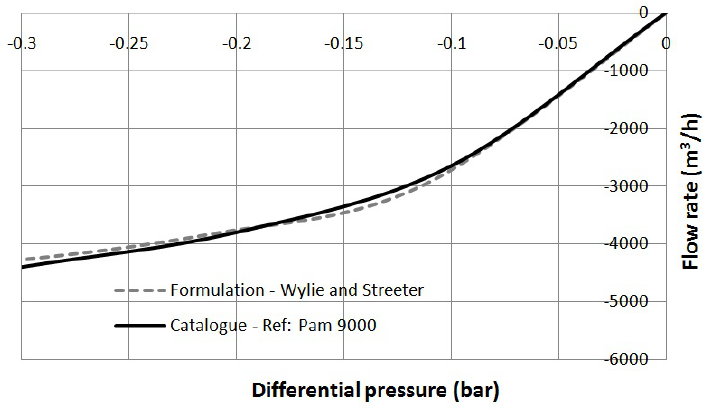
Figure 4. Characteristics of the air valve—Type 9000 Pam